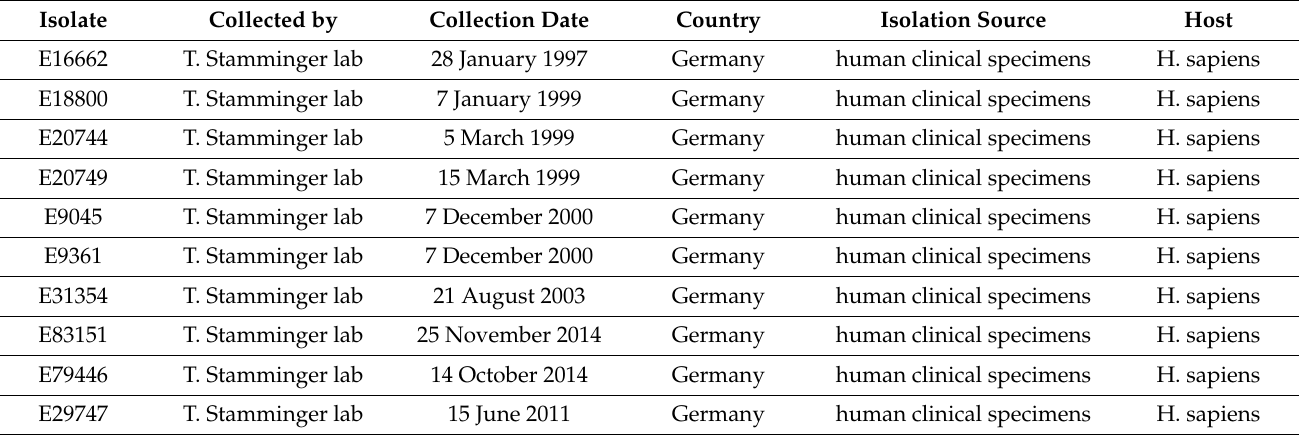
Table 3. Origins of clinical isolates used in this